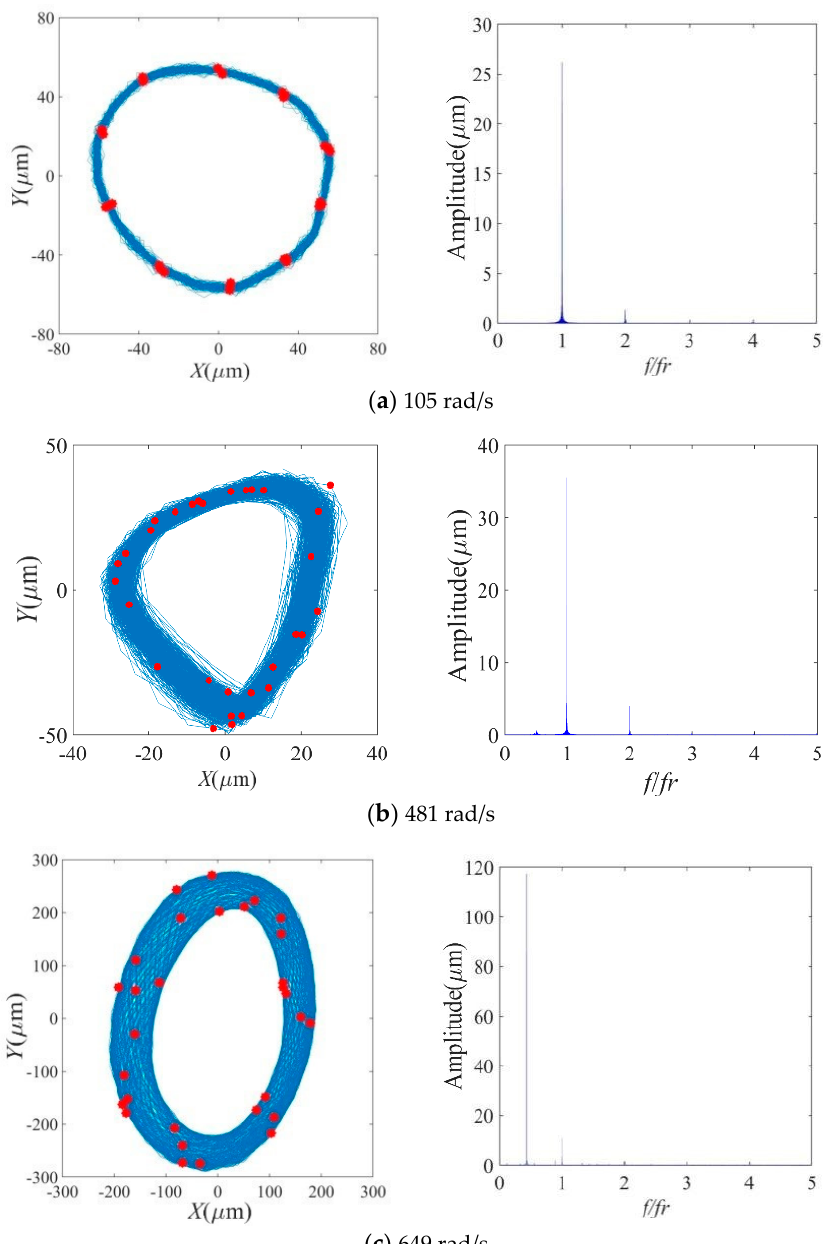
Figure 12. Trajectory of shaft center with the Poincaré map ( left side ) and the power spectrum ( right side ) for the rotating disk at different rotating speeds.